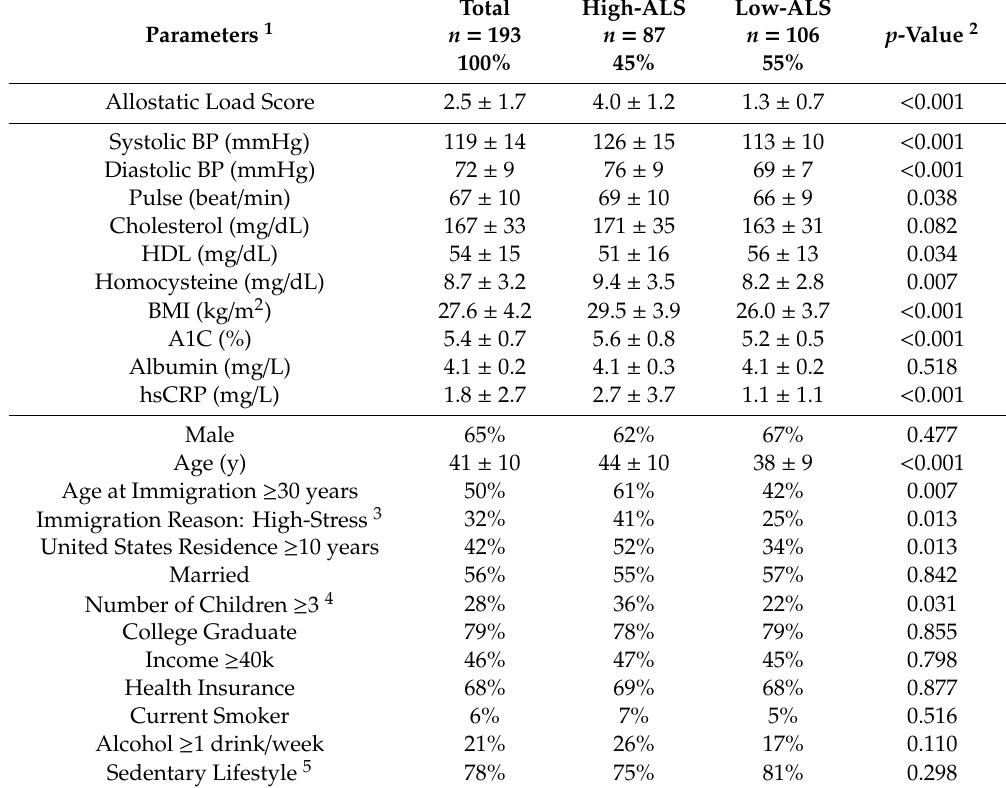
Table 2. Participant characteristics with High-allostatic load score (ALS) (ALS ≥ 3) and Low-ALS (ALS <